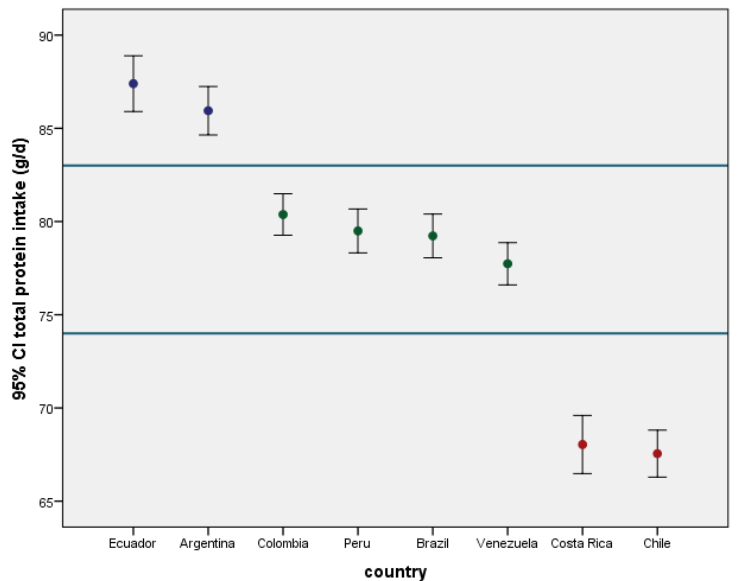
Figure 1. Mean protein intake (g/day) by ELANS countries with standard error bar.